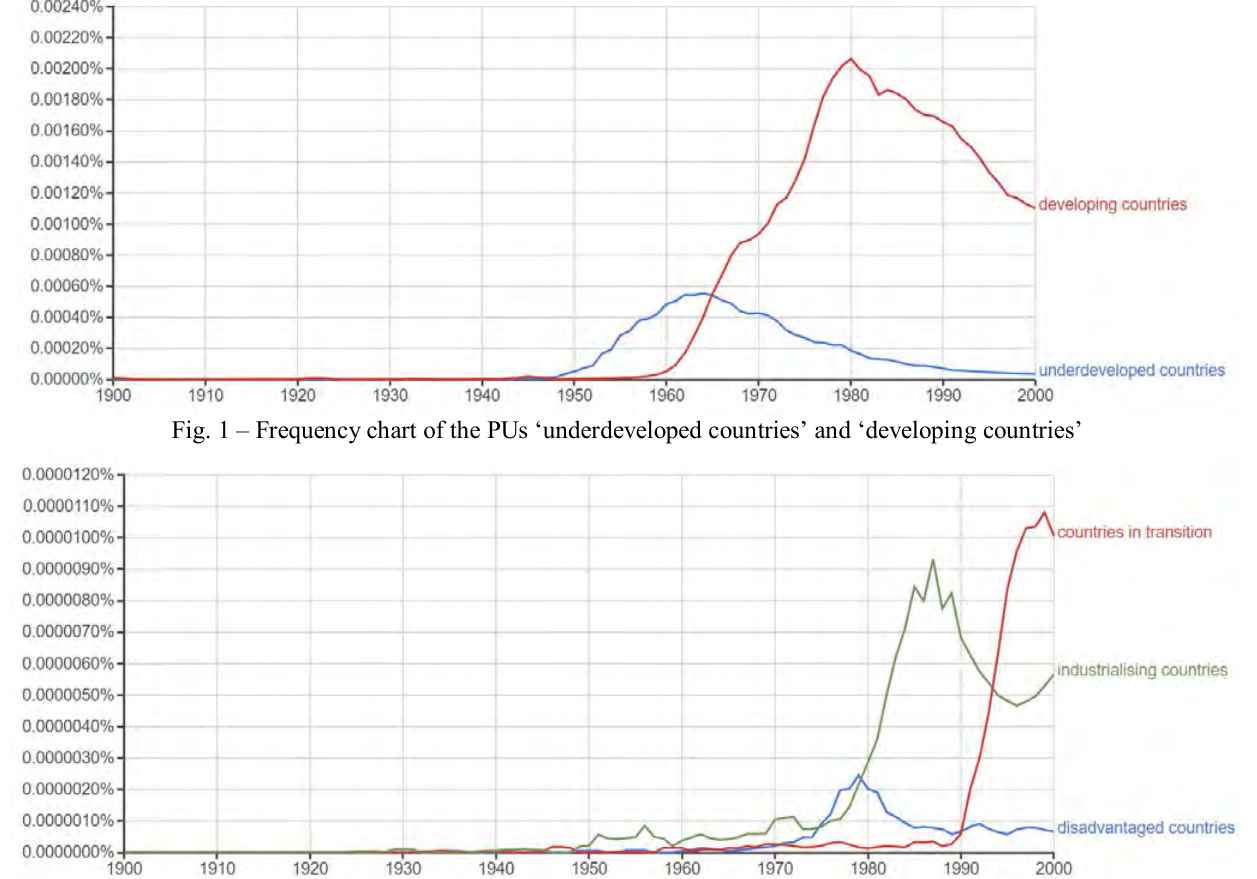
Fig. 2 – Frequency chart of the PUs ‘disadvantaged countries’, ‘developing countries’ and ‘countries in transition’ The study finds that all the highlighted PUs with the element ‘country’ have been able to perform a euphemistic